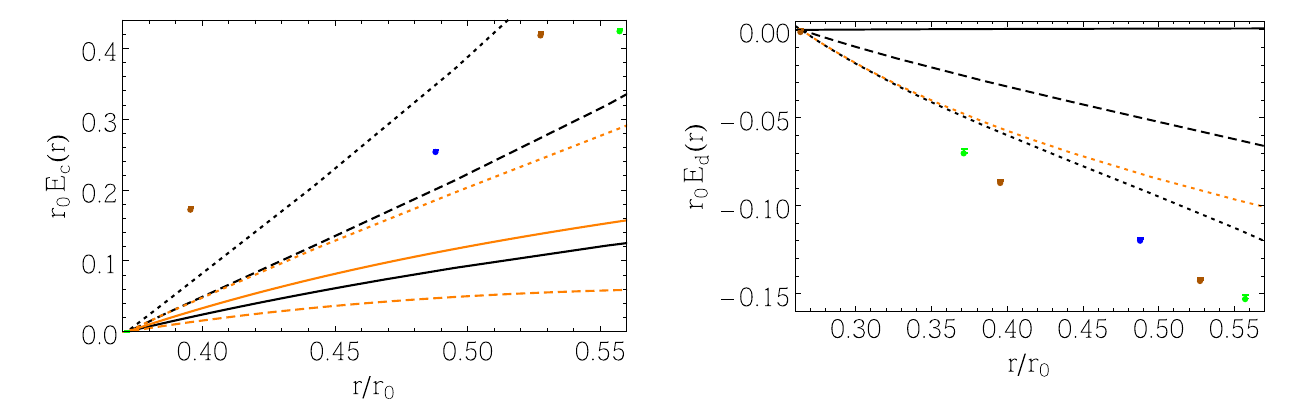
Fig. 7 Comparisontothelatticedatafor E c .Thesolidlinescorrespond to the LO (orange) and NLO results (black) at fixed scale ν = 2 × . The dashed lines correspond to the LO (orange) and 1 / 0 . 371627 r − 1 0 NLO (black) results setting ν = 1 / r . The dotted lines correspond to the LL (orange) and NLL (black) results setting ν us = C A α(ν)/ r and ν = 1 / r